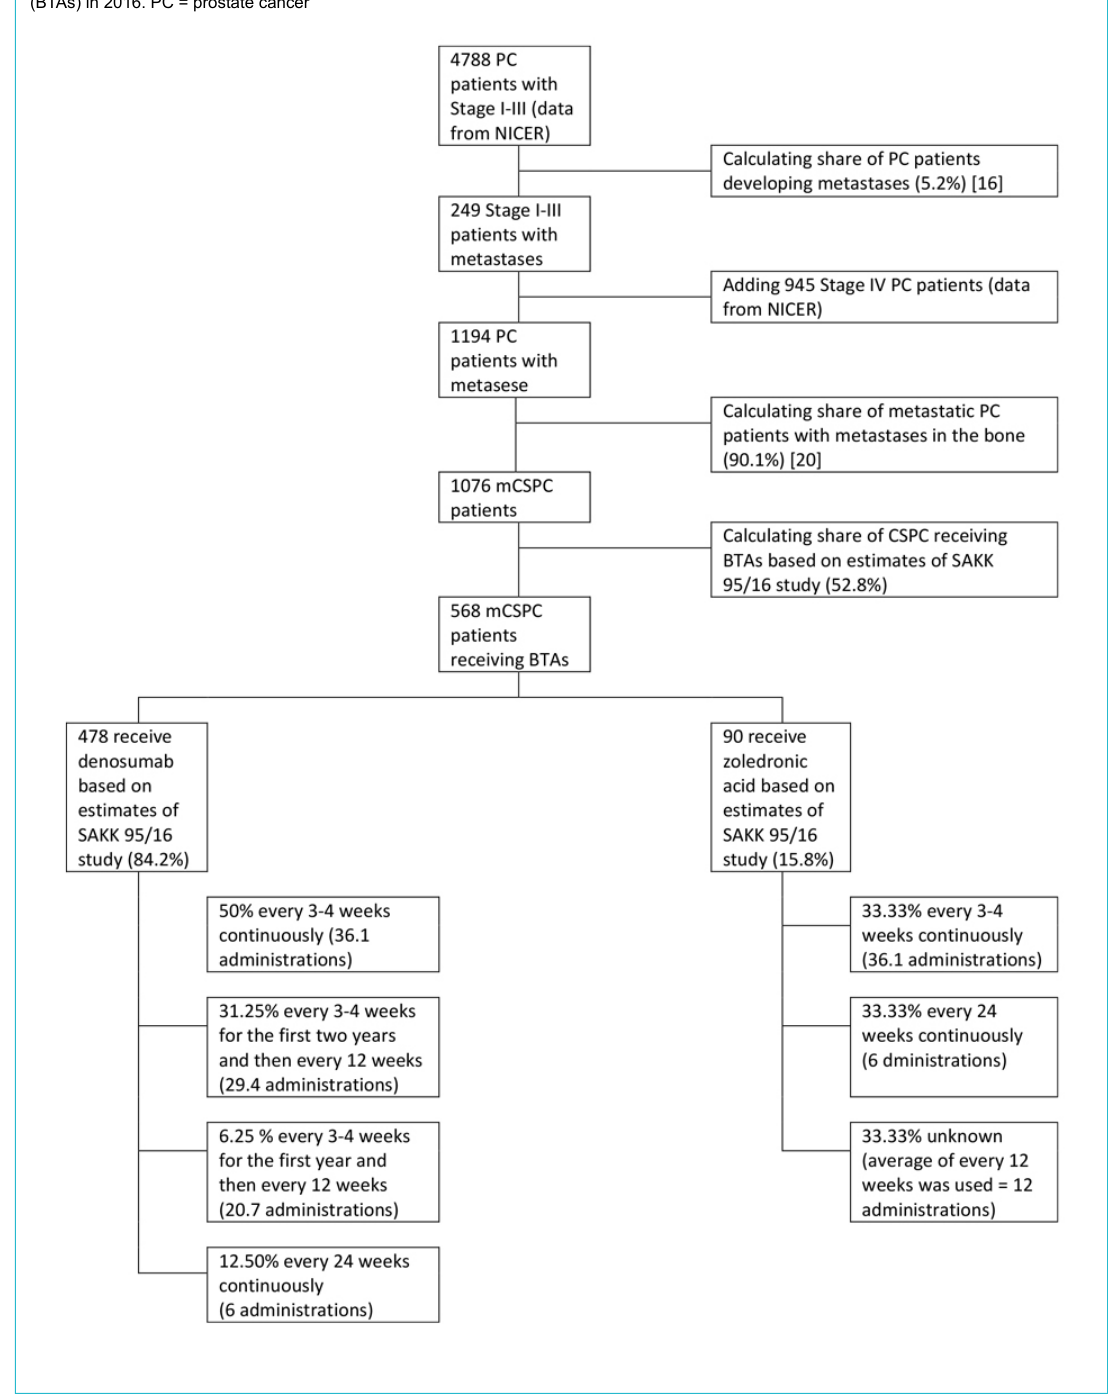
Figure 1: Estimation of the Swiss metastatic hormone-sensitive prostate cancer (mCSPC) population that received bone-targeted agents (BTAs) in 2016. PC = prostate